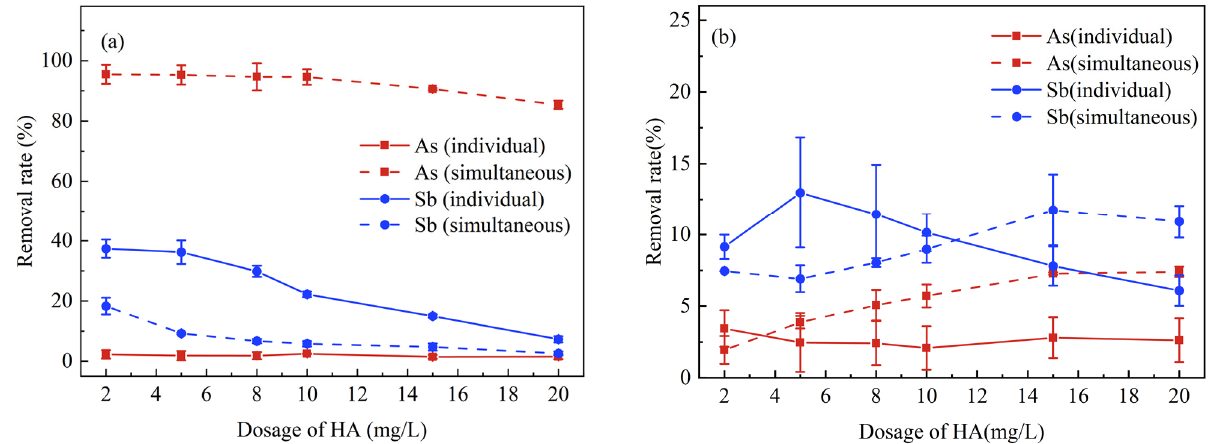
Figure 4. Comparison of HA dosing on the removal of As(III) and Sb(III) between individual and simultaneous treatments (( a ) K 2 FeO 4 treatment; ( b ) no K 2 FeO 4 ).